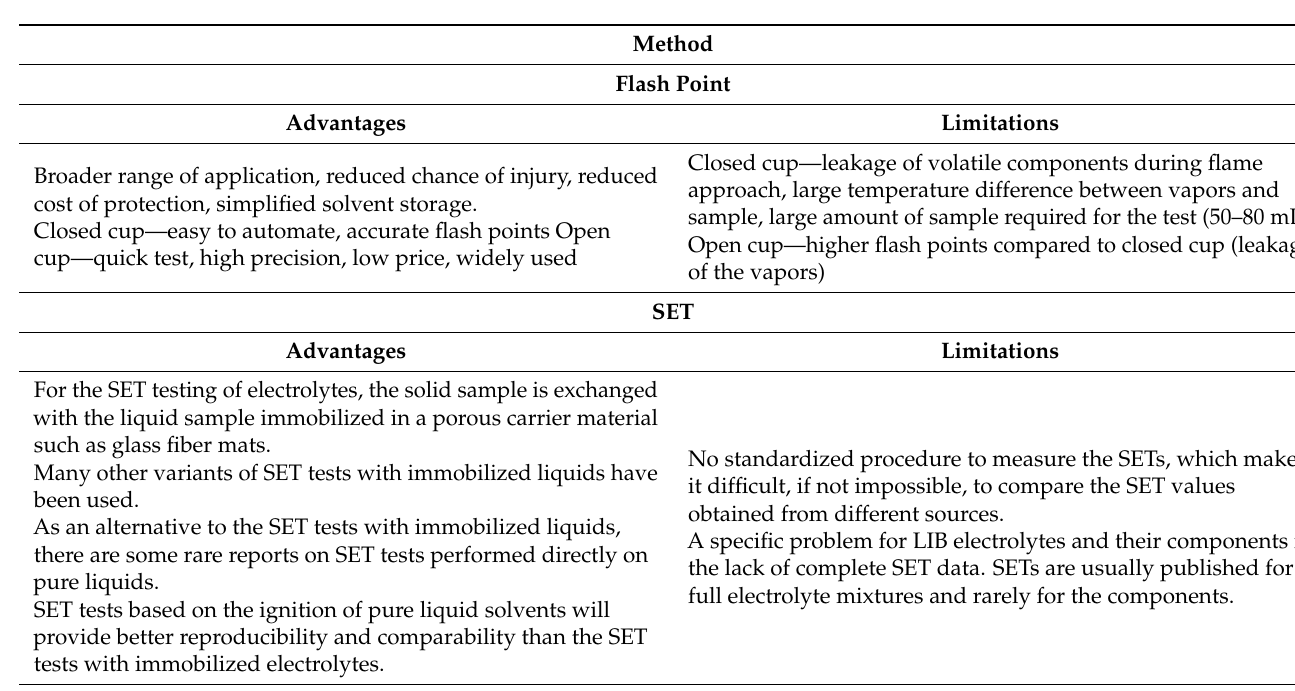
Table 7. Standardized methods for the FS